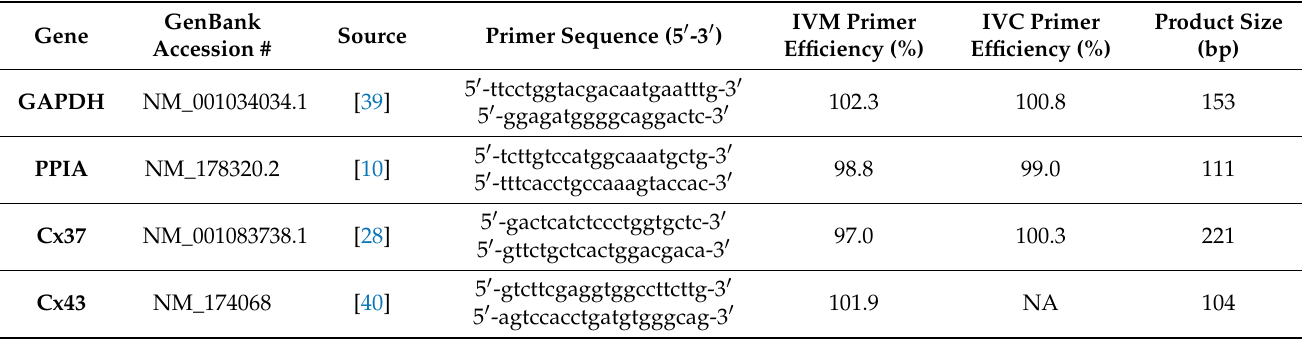
Table 1. Primers used in